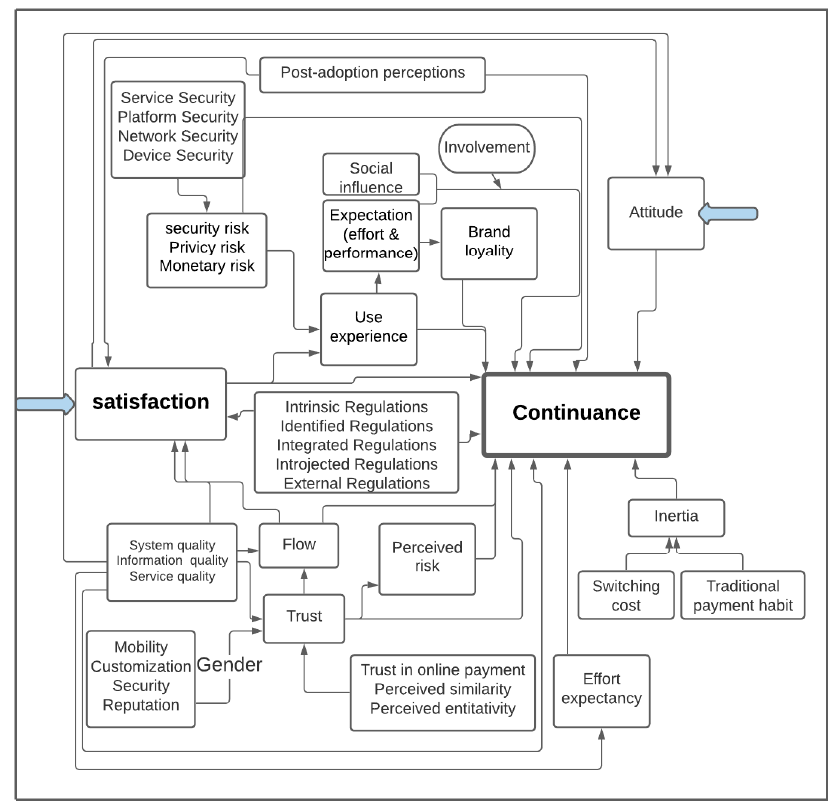
Figure 7. The continuance model of electronic payment.